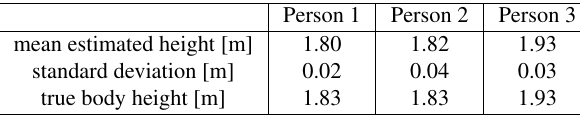
Table 1: Mean estimated body height and ground truth for differ- ent people in the